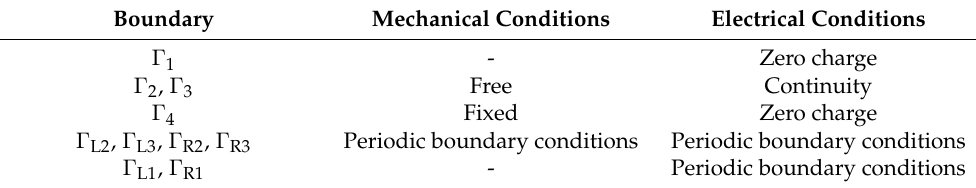
Table 4. Boundary conditions used in the 2D model of Figure 2a.